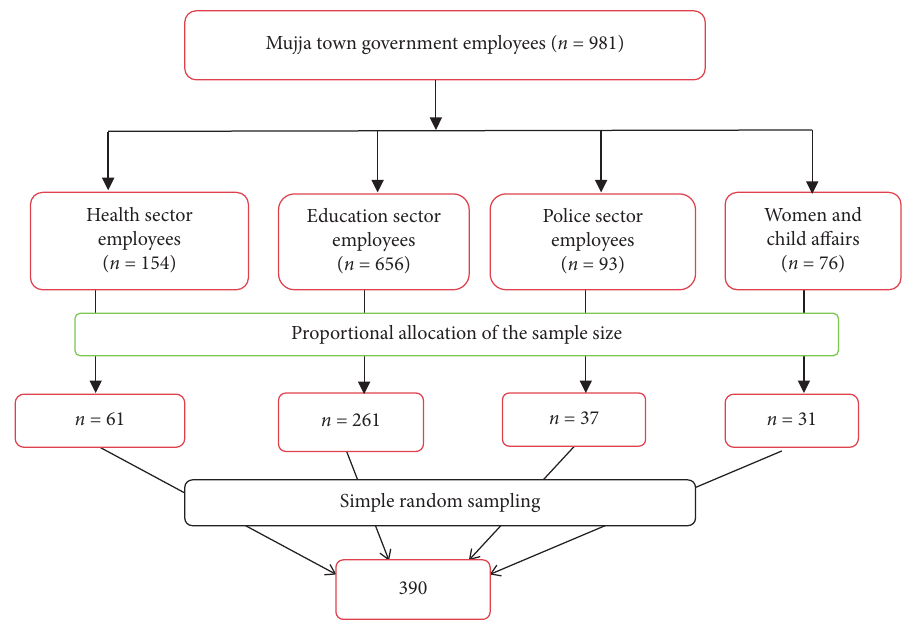
Figure 1: Schematic representations of the sampling procedure for willingness to pay to SHI and associated factors among government employees in Mujja town, northeast